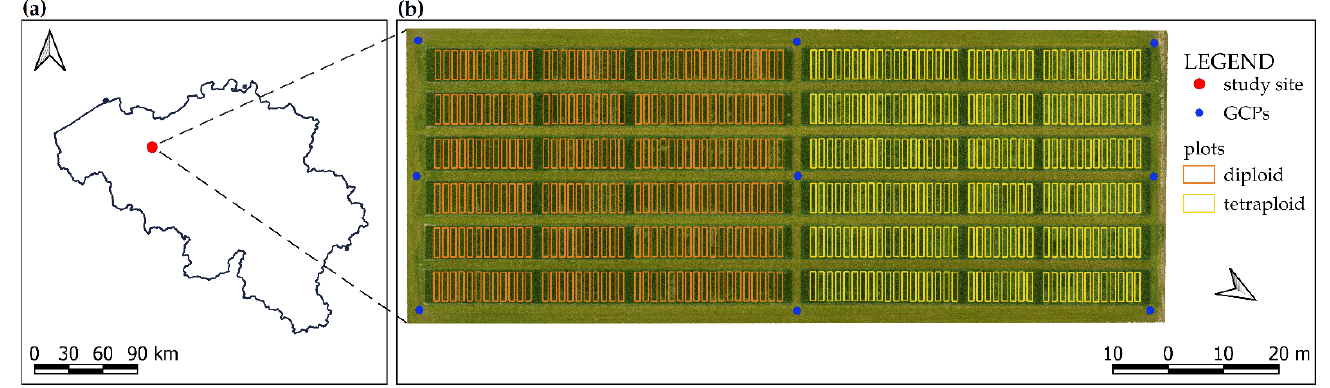
Figure 1. Schematic overview of ( a ) the study site location in Merelbeke, Belgium, and ( b ) the experimental plot design with diploid and tetraploid varieties and breeding populations.